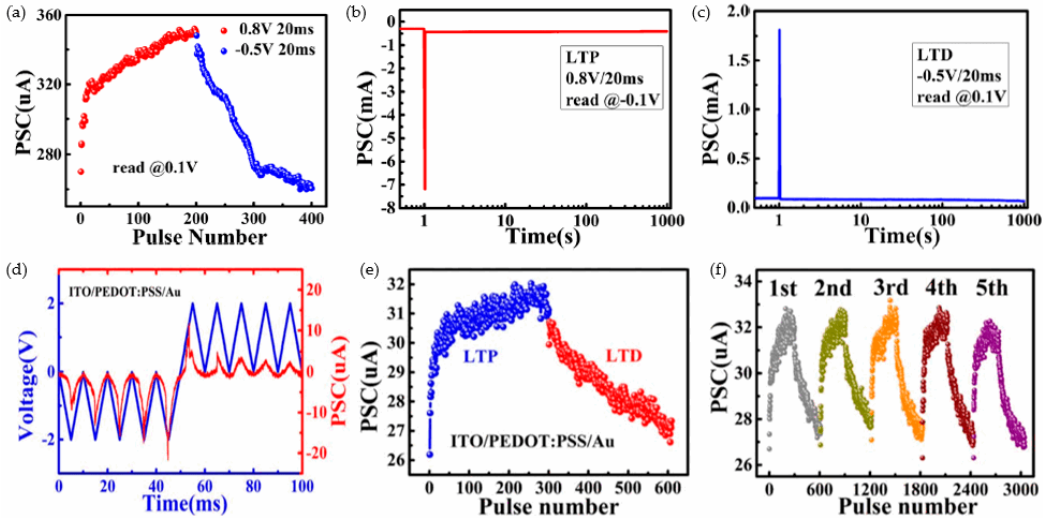
Figure 13. ( a ) Gradual modulation for conductance with long-term potentiation/depression response of Ag/HZO/ITO/PET RRAM device. Retention performance of Ag/HZO/ITO/PET RRAM device in ( b ) long-term potentiation process by consecutive positive pulses and ( c ) long-term depression process by consecutive negative pulses, reproduced from [79], with permission from Springer Nature, 2019. ( d ) Synaptic weights modulation of Au/PEDOT:PSS/ITO RRAM device by 10 consecutive pulses. ( e ) Long-term potentiation/depression under 600 consecutive pulses in one operation and ( f ) five operations of long-term potentiation/depression for Au/PEDOT:PSS/ITO RRAM device, reproduced from [163], with permission from MDPI (Basel, Switzerland), 2018.